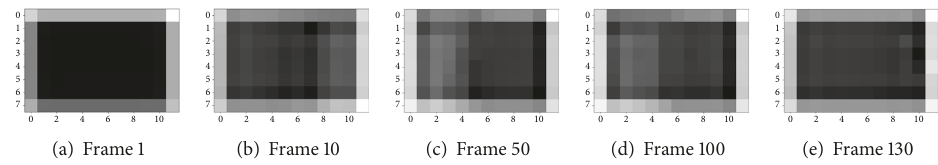
Figure 6: Image generated from the 1 st 𝐺𝑈 output (Layer 2), 𝜏 = 1.3 .